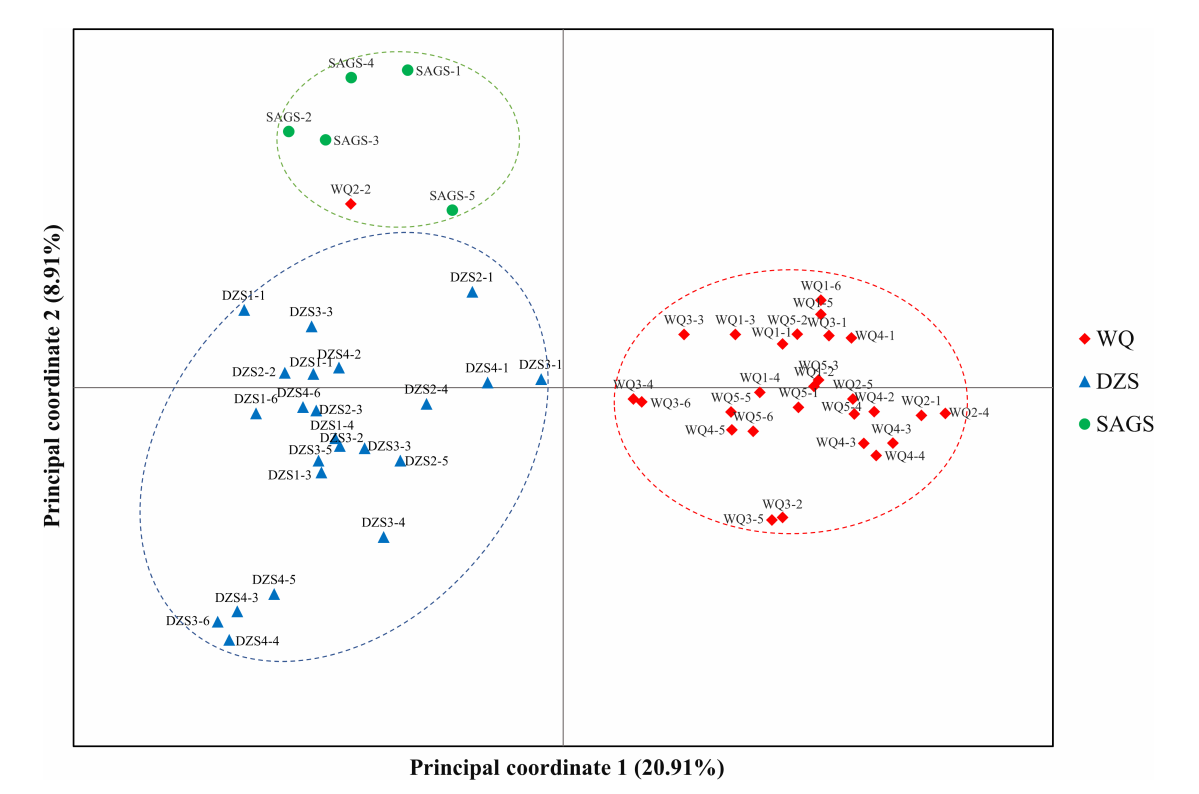
FIGURE7 The PCoA analysis of 56 K. melanthera individuals based on 49 developed SSR